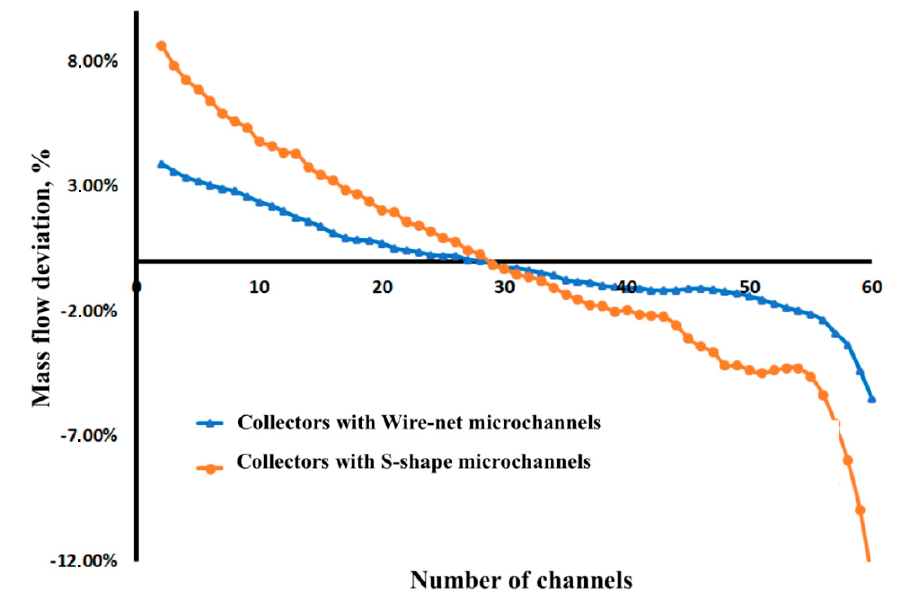
Figure 5. Mass flow rate deviation of perturbators based on Reduced Order Model (ROM).